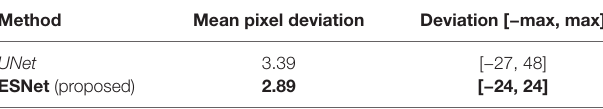
TABLE 2 | Comparison of different networks on the paddy line dataset.